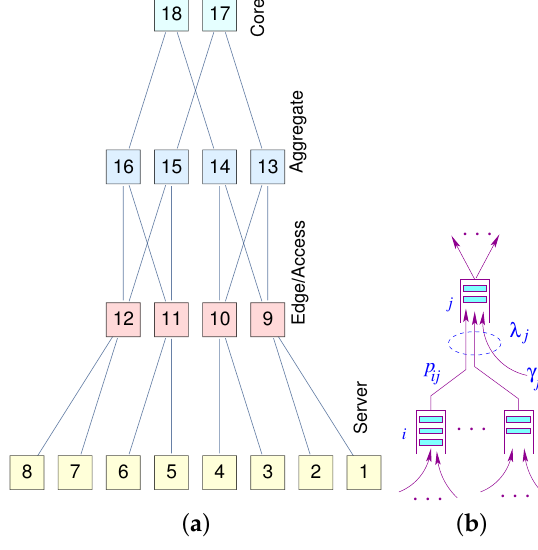
Figure 8. ( a ) A 4 × 16 fat-tree; ( b ) A node